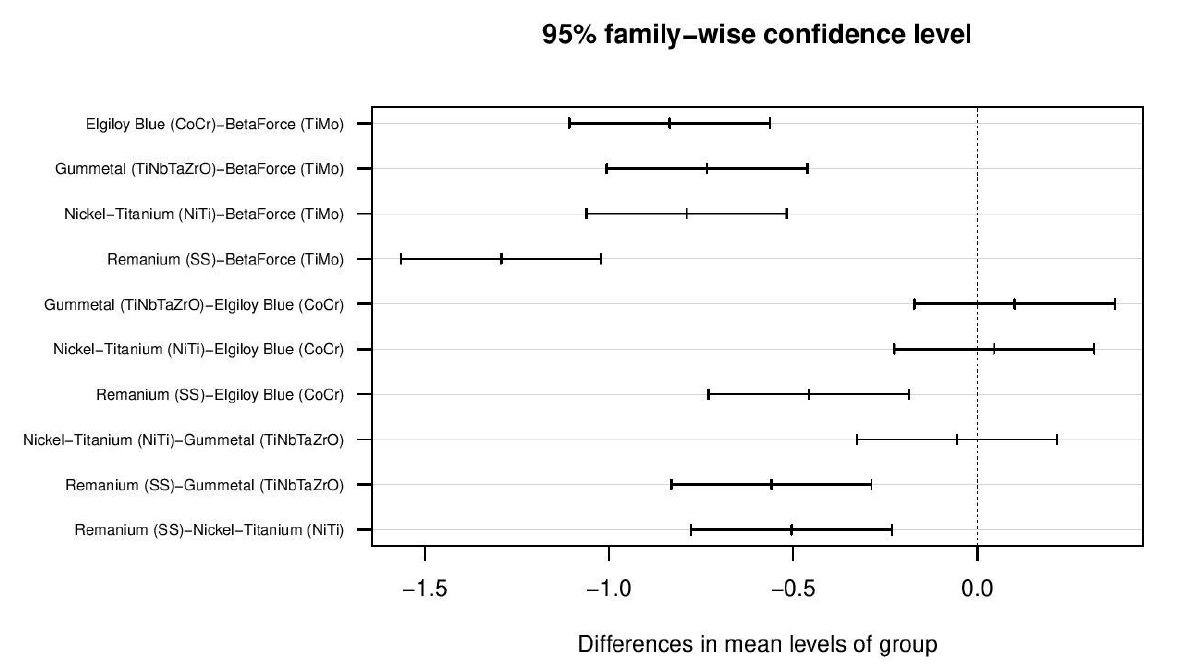
Figure 4. Pairwise group means differences in the form of confidence intervals. Table 6. Presence (+)/absence ( − ) of statistically significant differences between the sample group means ( p -value < 0.05). Remanium Orthodontic Wire